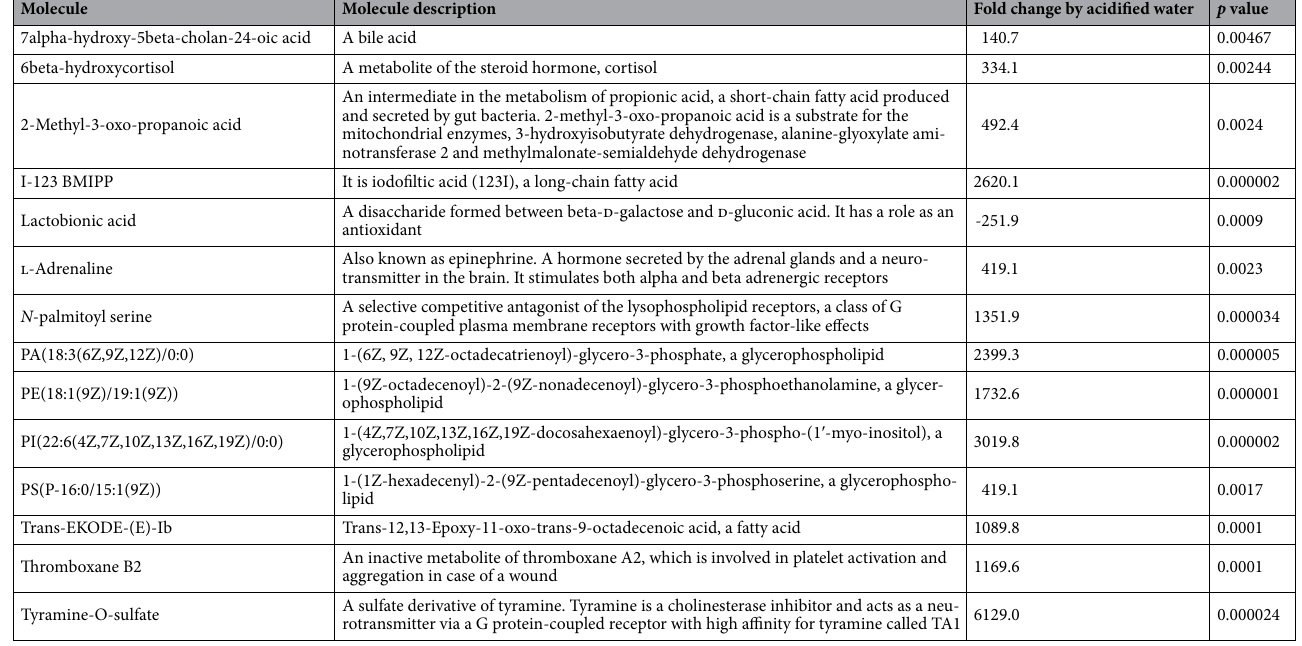
Table 1. Selected fecal metabolites with large, HCl-acidified drinking water-induced level changes (n = 6 mice). Molecule descriptions are from PubChem (https ://pubch em.ncbi.nlm.nih.gov/) and in the case of N -palmitoyl-serine from Liliom et al . 74 . P values were calculated using unpaired t-test with Benjamini– Hochberg correction for multiple